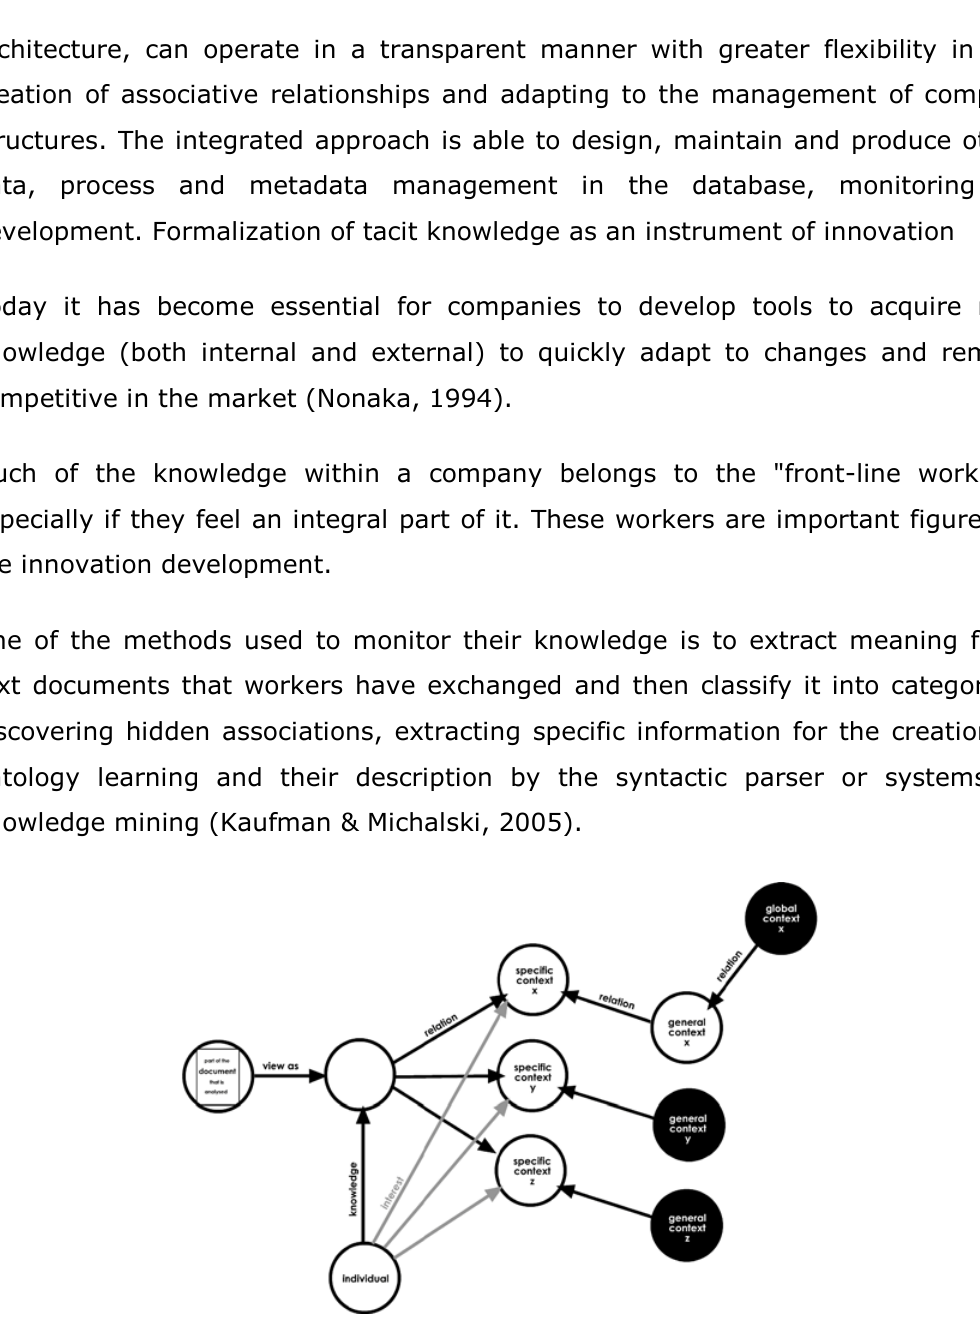
Figure 1. “Example of conceptualization